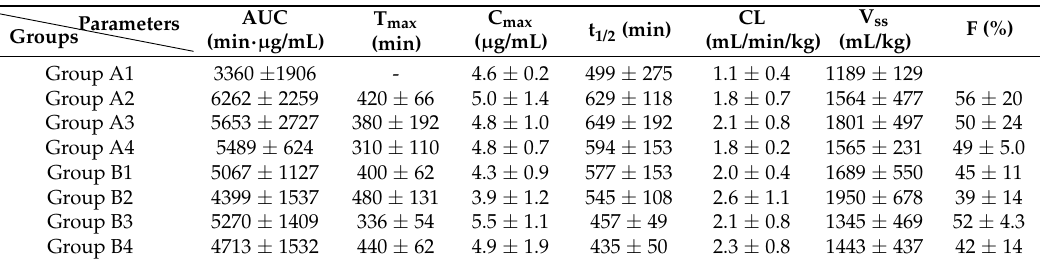
Table 1. Pharmacokinetic parameters in rats treated with sorafenib alone and pretreated with the LDXGT formulation, grapefruit juice and ketoconazole.